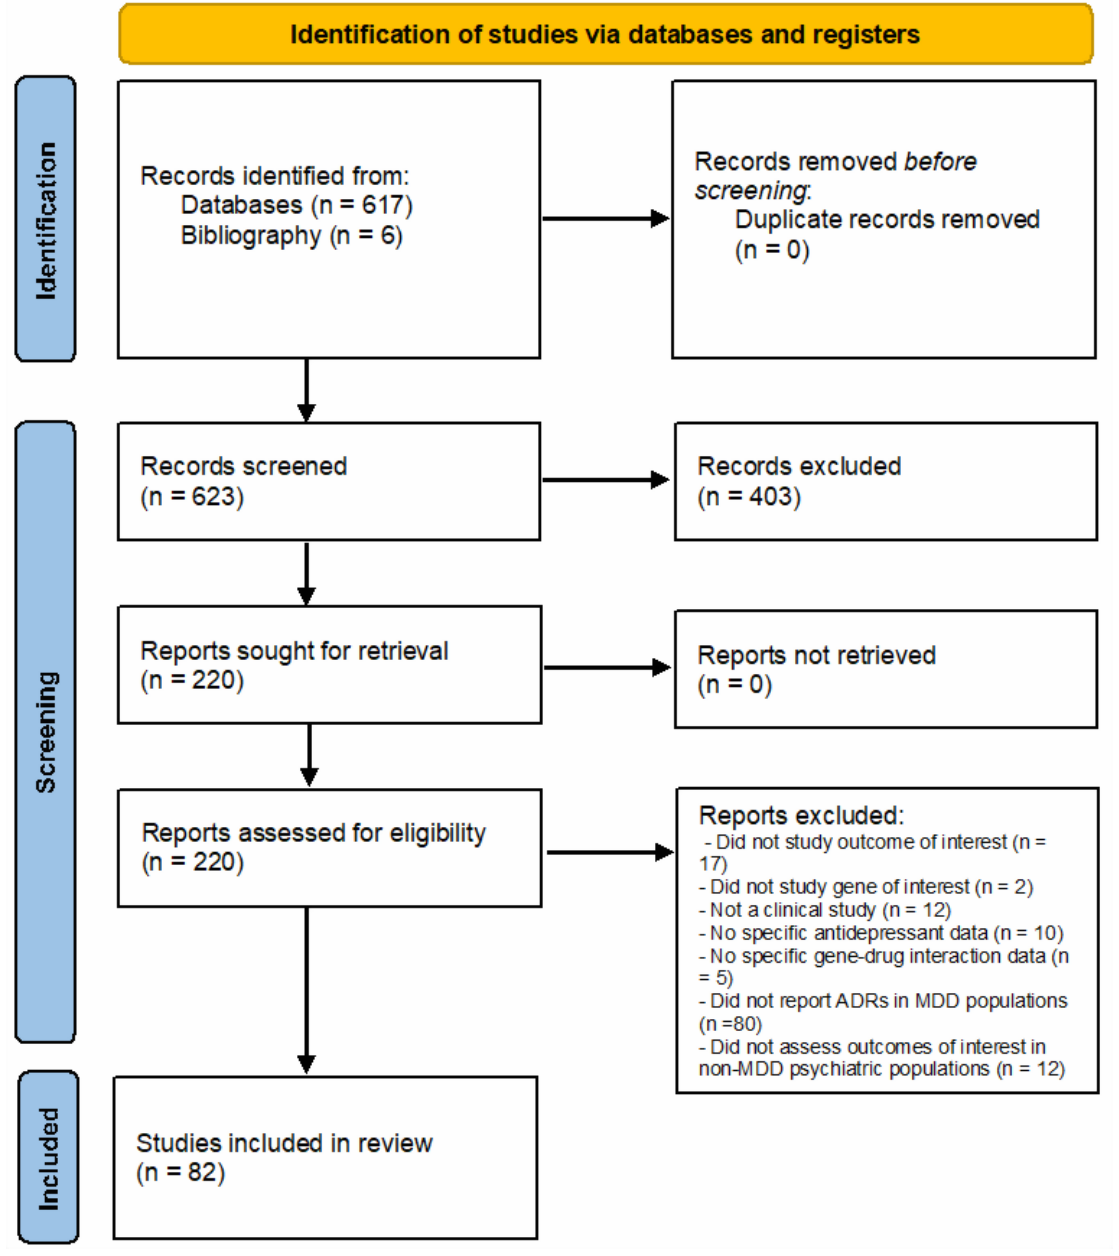
Figure 1. PRISMA flow chart detailing the article selection process.